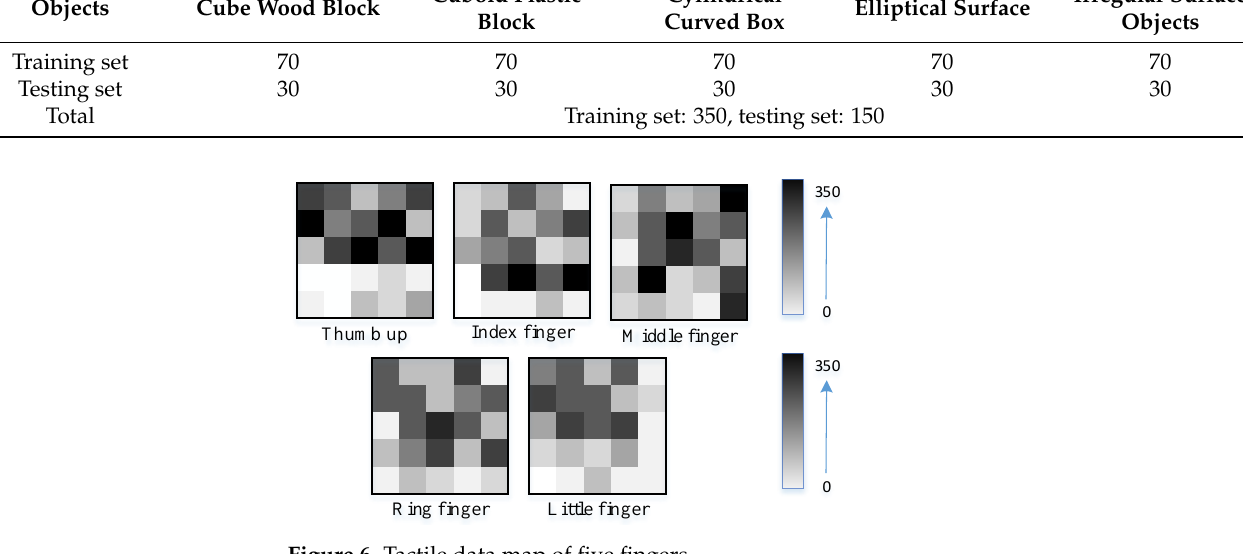
Figure 6. Tactile data map of five fingers.